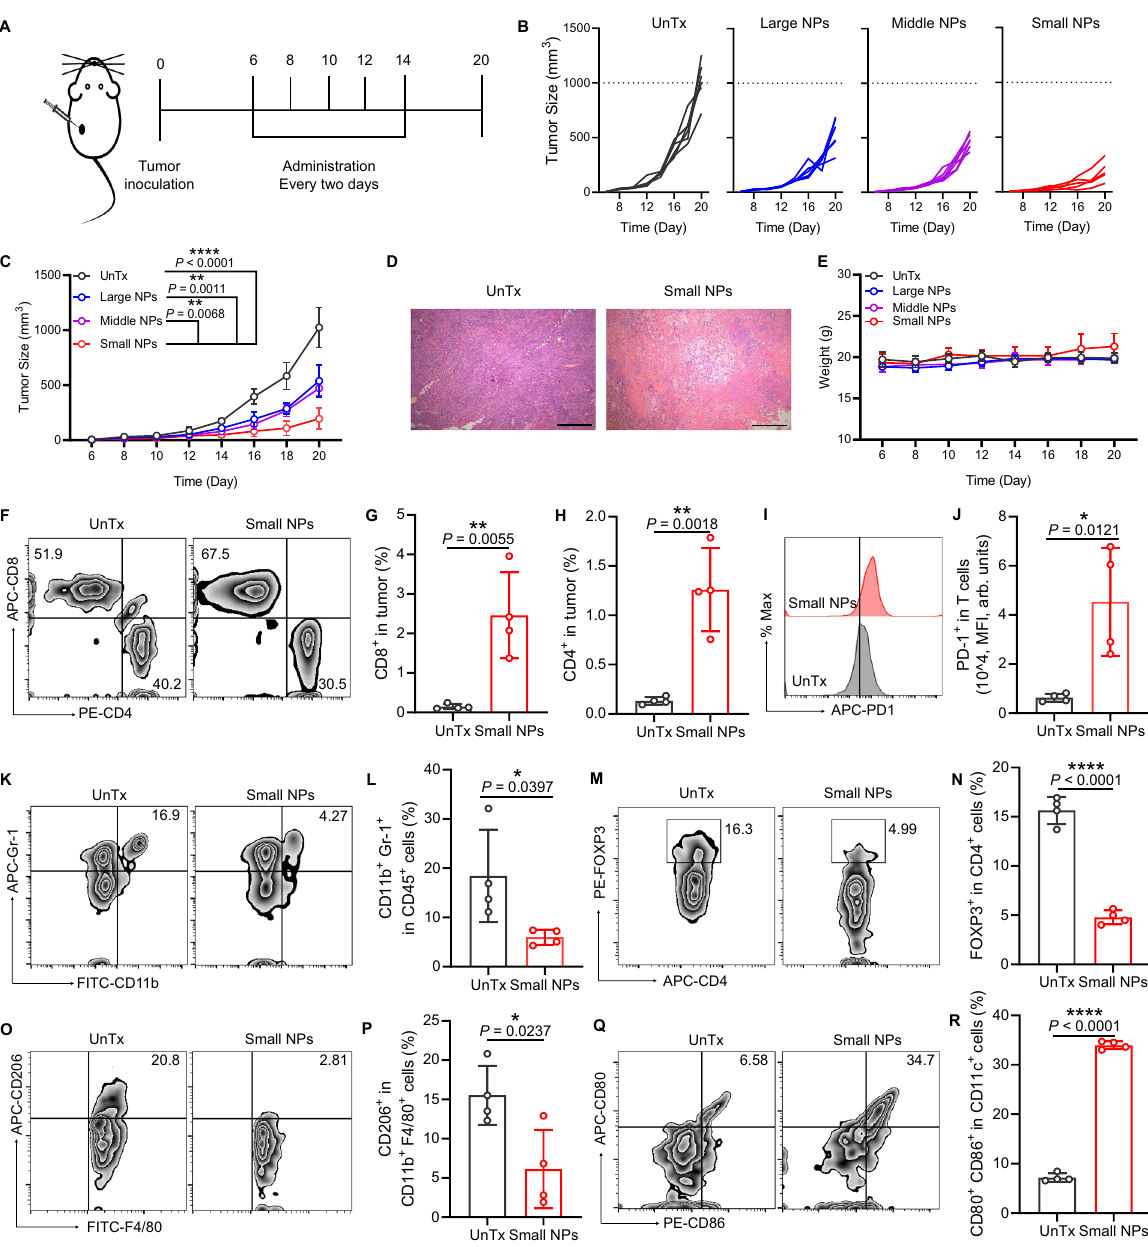
Fig. 3 YCW NPs inhibited tumor growth by remodeling immunosuppressive tumor microenvironment. A Schematic diagram of therapeutic strategy with YCW NPs, including large NPs, middle NPs and small NPs. B – C Individual ( B ) and average ( C ) tumor growth curves in groups of untreated and treated with three different sizes of YCW NPs (UnTx: n = 6; Large NPs: n = 6; Middle NPs: n = 6; Small NPs: n = 5). D Representative H&E staining image of tumors in untreated and small size of YCW NPs treated group (Scale bar = 200 µ m, n = 3). E Weight of mice of four different groups during treatment (UnTx: n = 6; Large NPs: n = 6; Middle NPs: n = 6; Small NPs: n = 5). F Representative fl ow cytometric analysis for CD8 + and CD4 + in tumors and ( G – H ) corresponding quantitative analysis ( n = 4) of untreated group and small NPs group. I Representative fl ow cytometric analysis for PD-1 + expression in T cells and ( J ) corresponding quantitative analysis. K – R Analysis of TME of untreated group and small NPs group. K Flow cytometry plots of MDSCs (CD45 + CD11b +